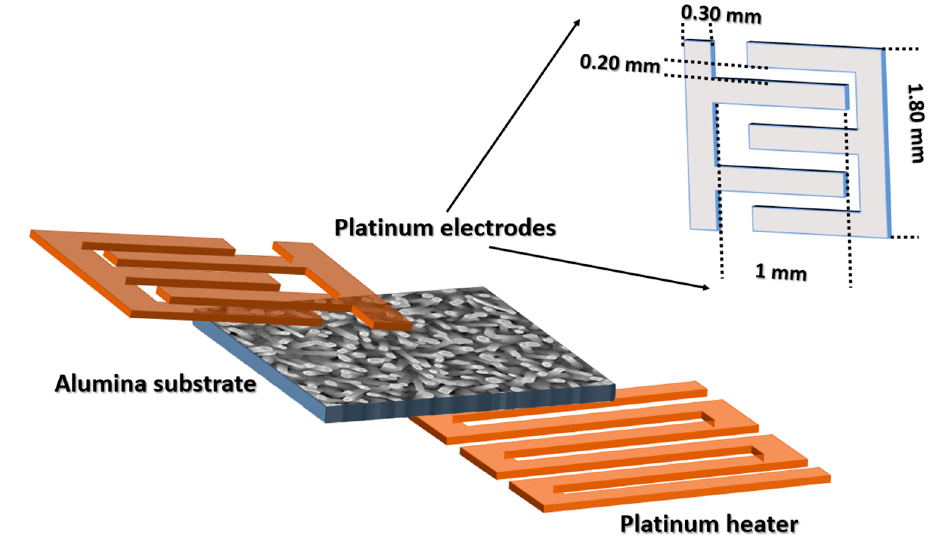
Figure 1. Design of conductometric sensor device.